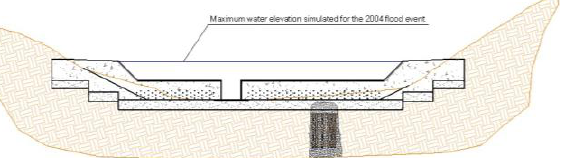
Figure 12 - Selective check dam structure: frontal view of Dam